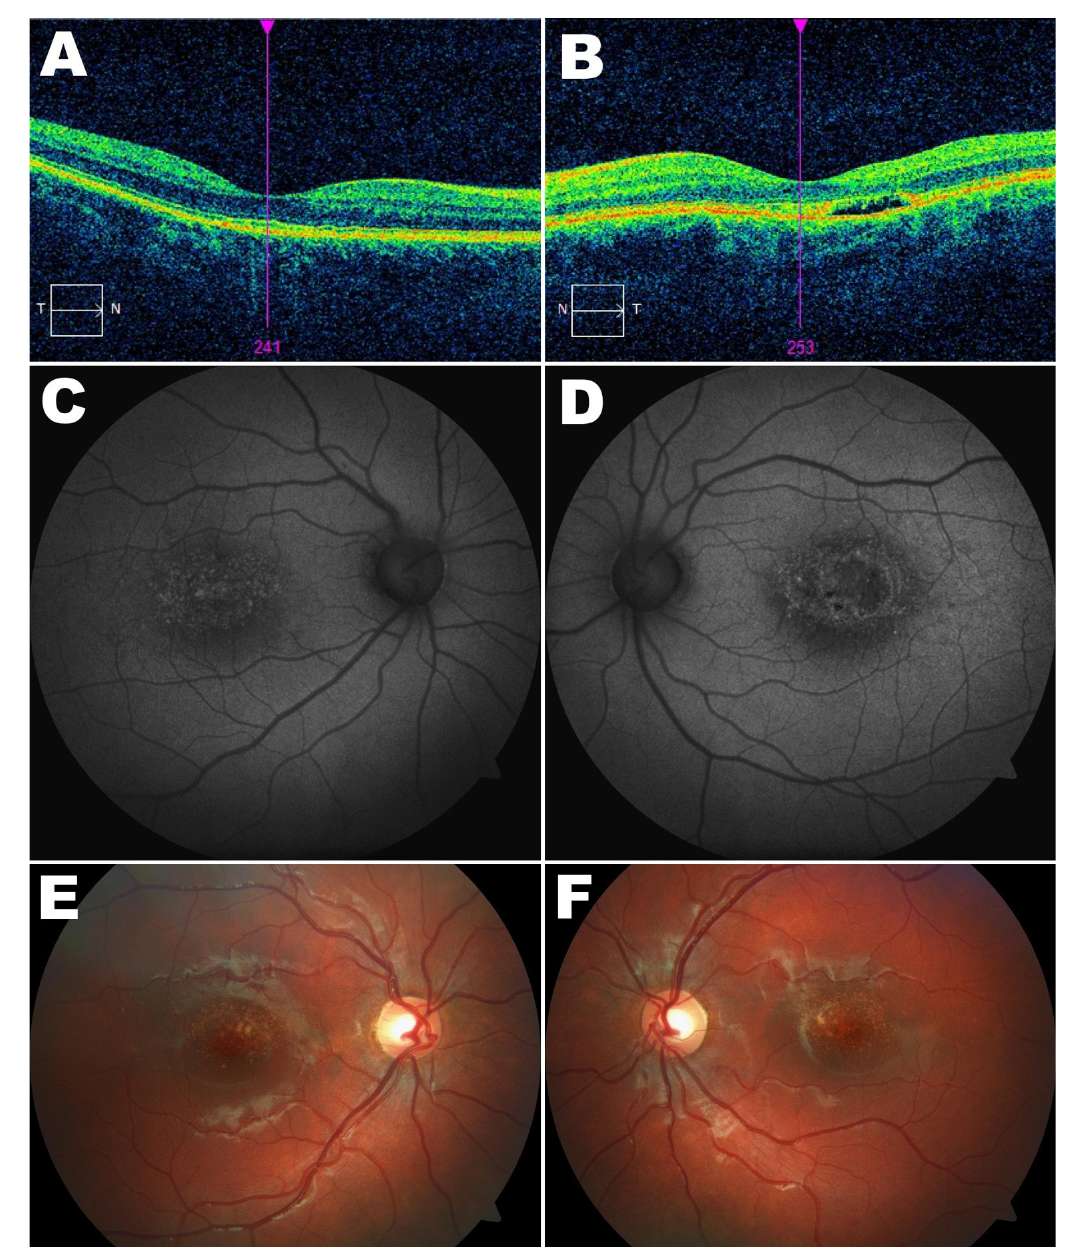
Fig. 2.A-D Patient 4. 2A. OCT of the right eye: foveal depression is present, focal RPE damage. 2B. OCT of the left eye: focal neurosensory detachment, area of the RPE damage. 2C. (Right eye) and 2D. (Left eye) FAF: The focal increased pattern with several well-defined spots with markedly increased FAF surrounded by a halo of decreased FAF. 2E-F. Patient 5. Fundus photography, non-volatile yellowish-white lesions in the macula. 2E. Right eye. 2F. Left